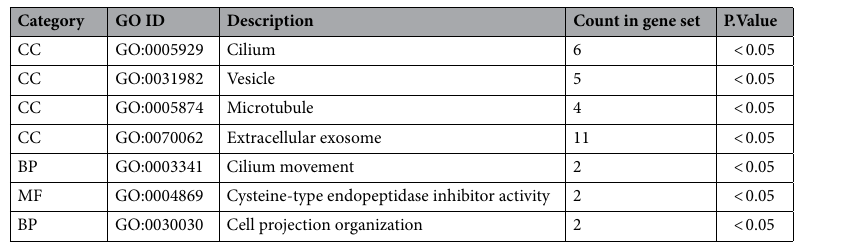
Table 3. GO function enhancement analysis of DEGs in NPC samples. CC cell component, BP biological processes, MF molecular